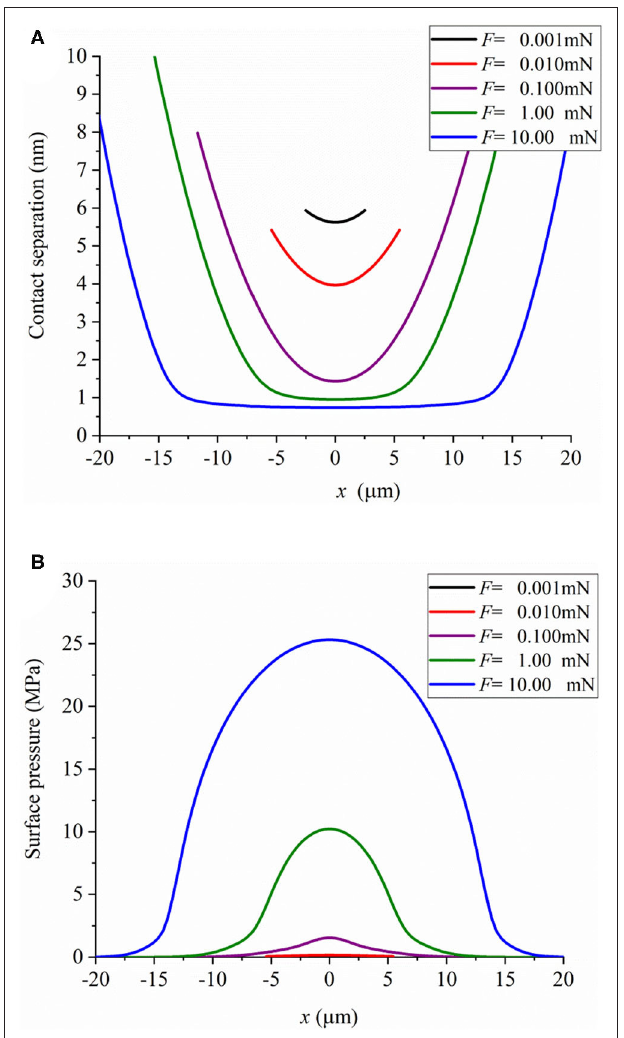
FIGURE 5 | (A) Contact profile and (B) surface pressure distribution under different loads.